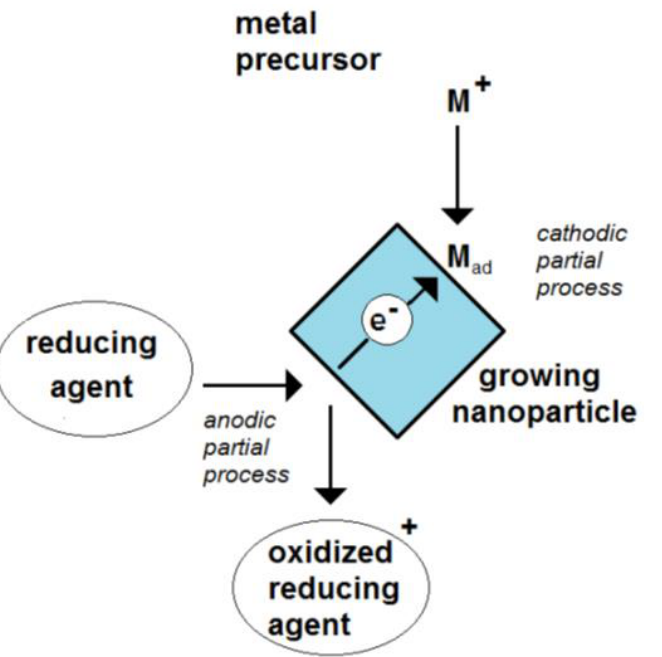
Figure 1. Scheme of the formation of an electrochemical mixed potential of a growing nanoparticle by the coupling of a cathodic and an anodic partial by the coupling of a cathodic and an anodic partial process.